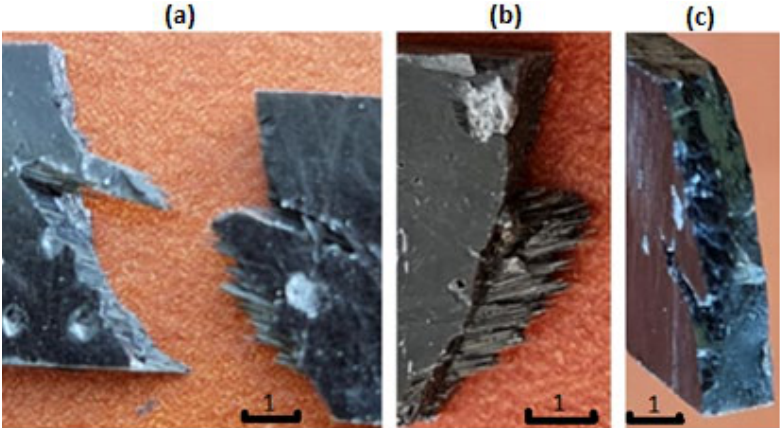
Figure 10. Fracture of exemplary composite samples after tensile tests—the composite reinforced with original carbon fibers: ( a ) two sides of the fractured sample, ( b ) magnified view of the fracture.